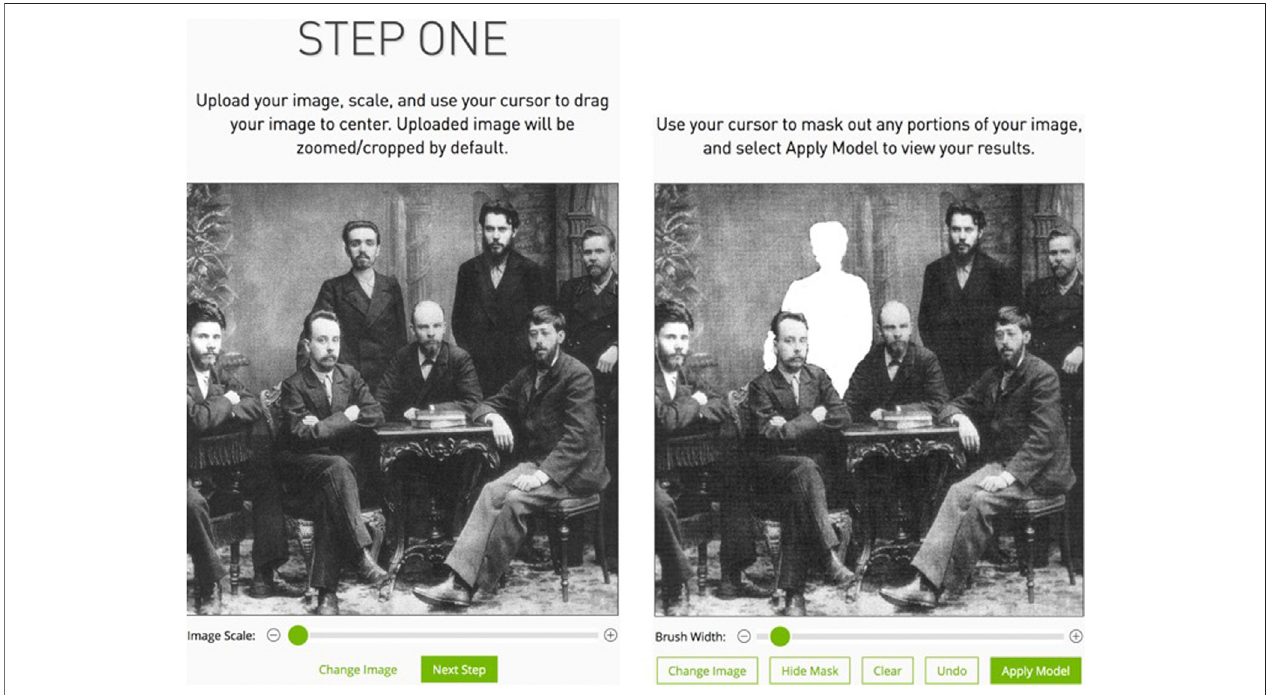
FIGURE 2 | Operation of NVIDIA Image Inpainting. Left: Image selection. Right: Selection of the contents to be removed. Source: Created by the authors using NVIDIA InPaint (NVIDIA, 2020). Image from Wikipedia (Wikipedia, 2020).